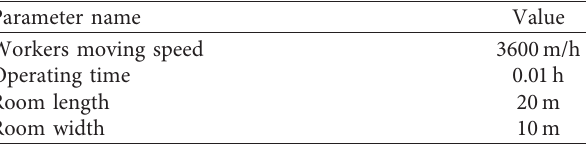
Table 3: Input data for the validation of dose optimization calculation.